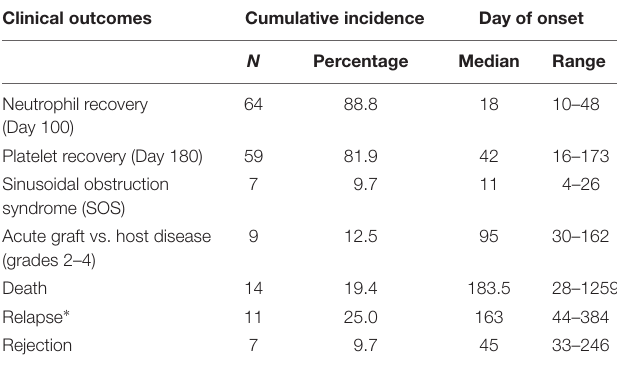
TABLE 3 | Cumulative incidences of clinical outcomes other than hemorrhagic